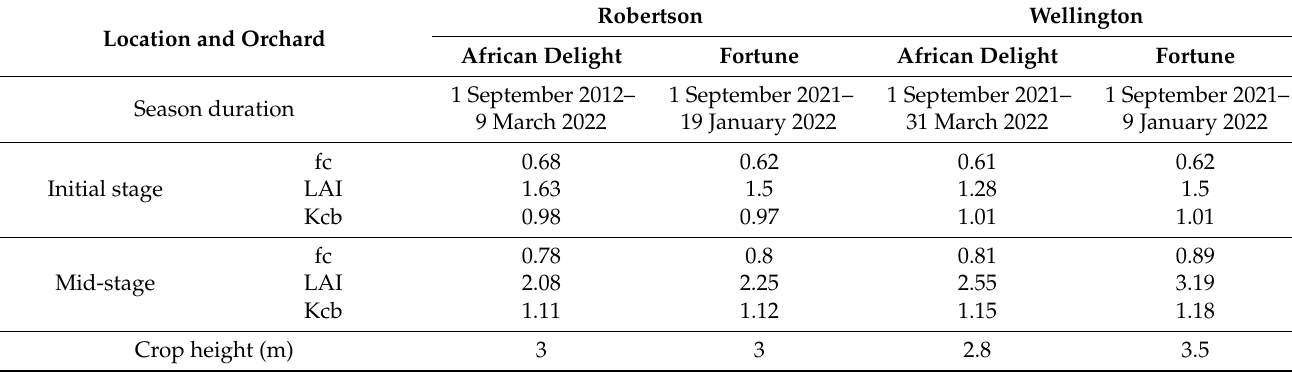
Table 3. Summary of duration of growing seasons (length of HYDRUS simulations) and canopy characteristics (canopy cover fc, leaf area index LAI, basal crop coefficient Kcb and crop height) for four Japanese plum